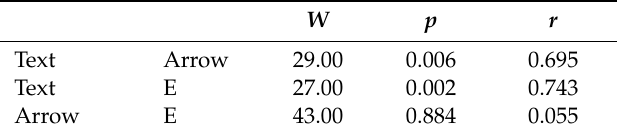
Figure 6. Content size from which the text and symbols were correctly identified ( n = 30). Table 4. Post-hoc comparisons using Wilcoxon tests.